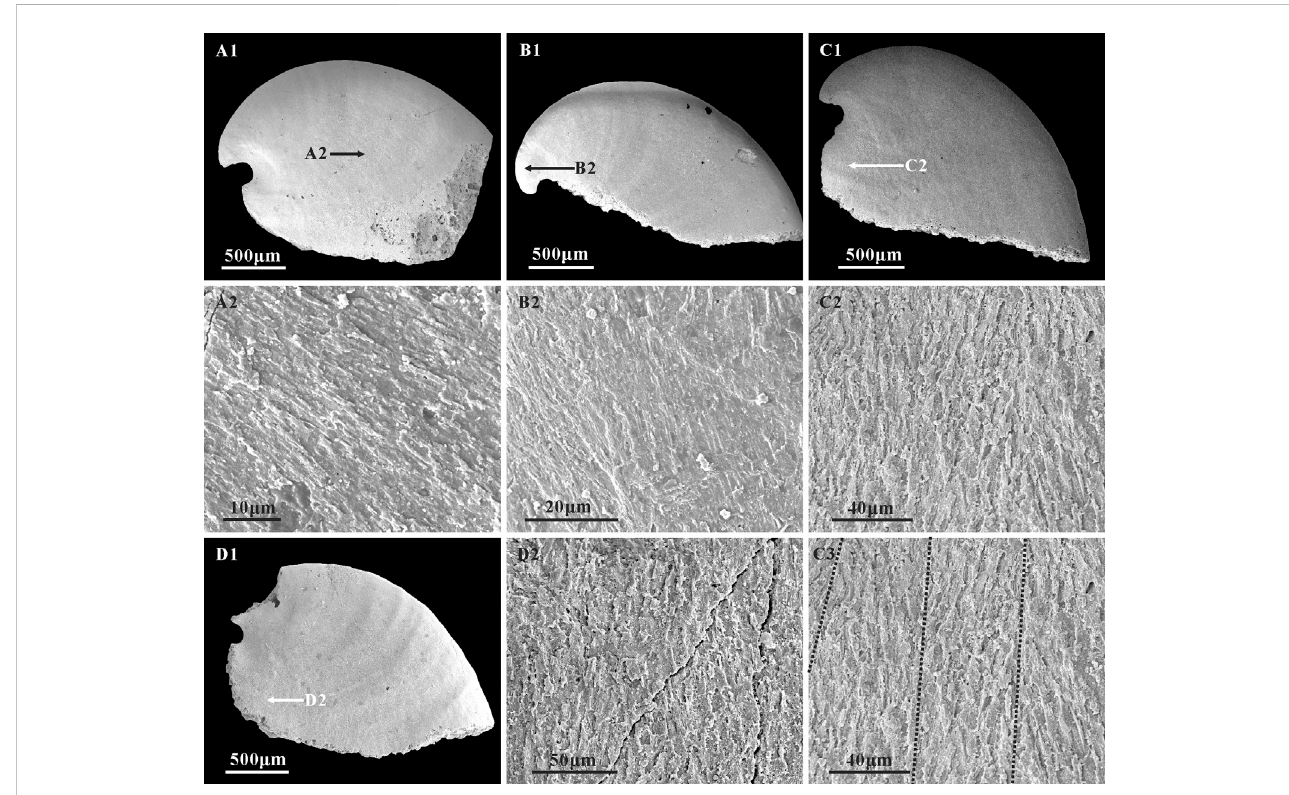
FIGURE 6 Lamello- fi brillar microstructure in the internal molds of A. plana . (A1,B1,C1,D1) Internal molds, lateral view, CUBar204-4, CUBar205-2, CUBar244-14, CUBar241-13,respectively. (A2,B2,D2) magni fi cationsof (A1,B1,D1) respectively, (C2,C3) magni fi cationsof (C1) ,showingthelamello- fi brillarmicrostructures. Black dotted lines on (C3) showing the convergence of different orientation fi bers. Specimens from the Member 5 of the Yanjiahe Formation in Gunziao Section. Arrows indicate magni fi ed